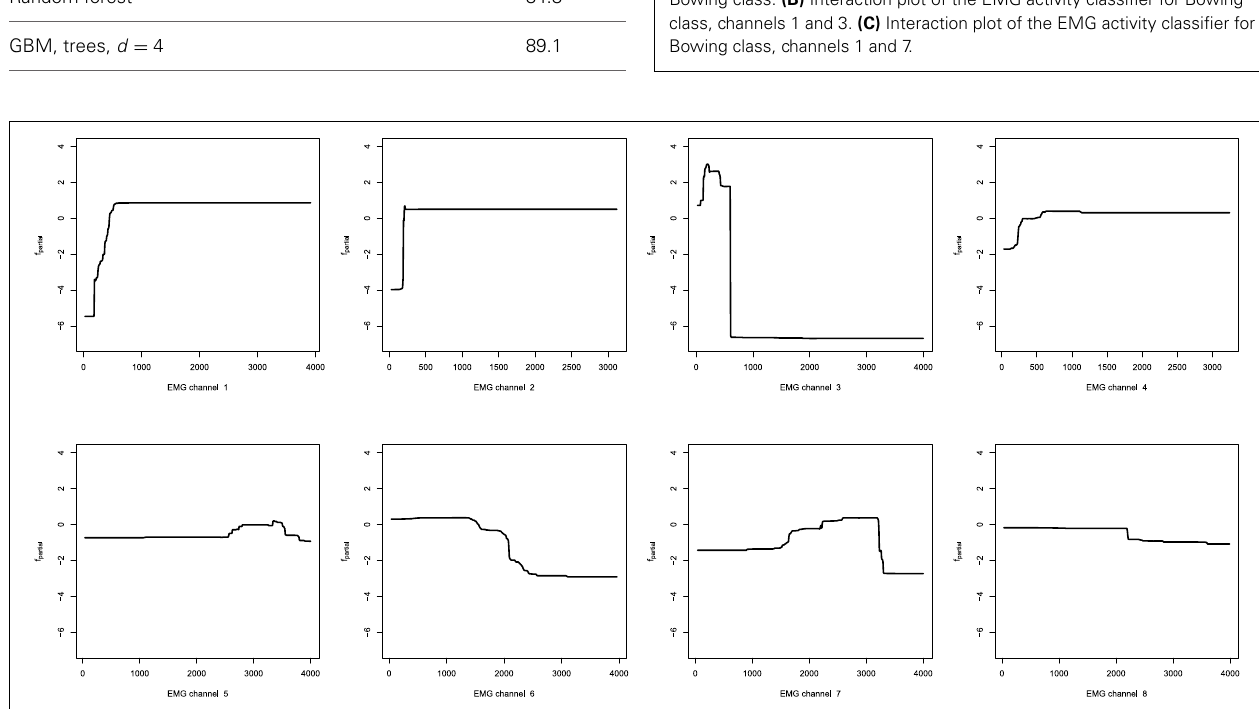
FIGURE 13 | Partial dependence plots for the EMG activity classifier based on the decision-tree GBM.